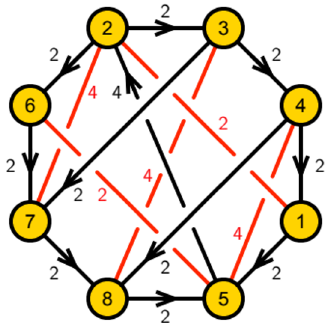
Figure 32 . Quiver for Model